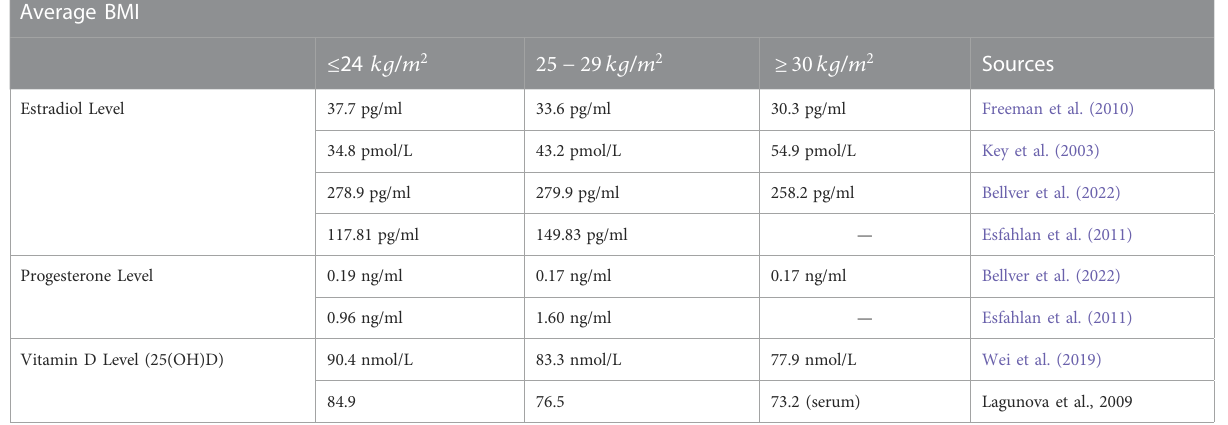
TABLE 4 Hormonal levels by